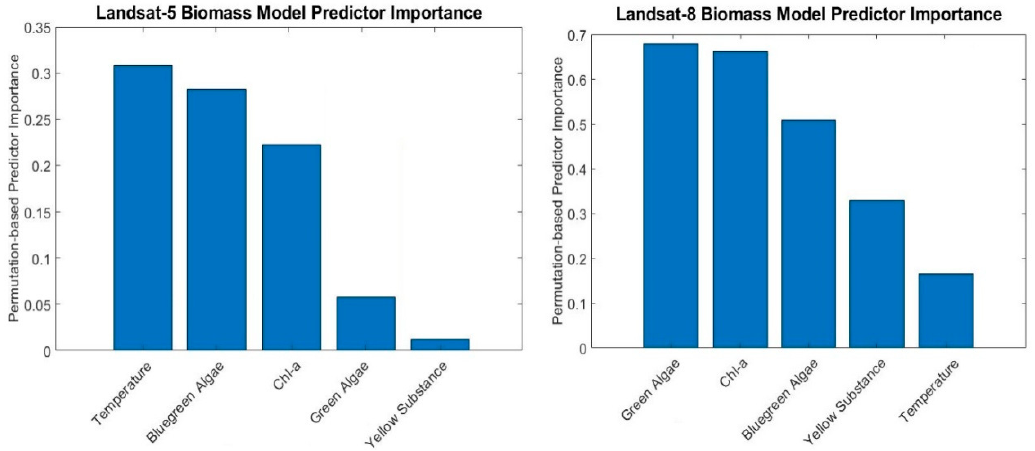
Figure 10. Out-of-bag predictor variable importance estimate for Landsat 5 (left) and Landsat 8 (right) fish biomass distribution model.